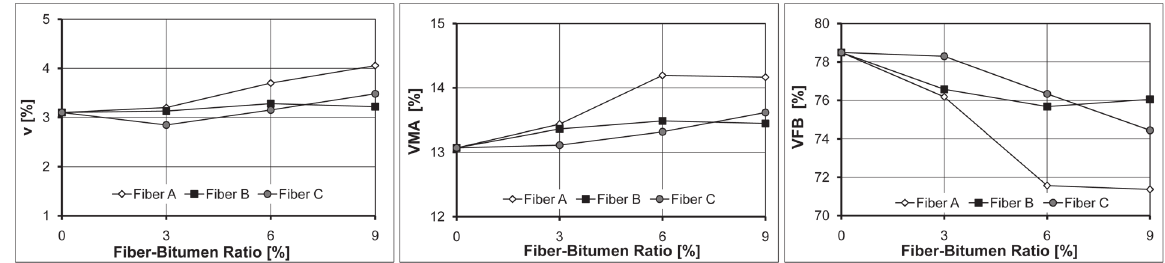
Fig. 9. Volumetric parameters of bituminous